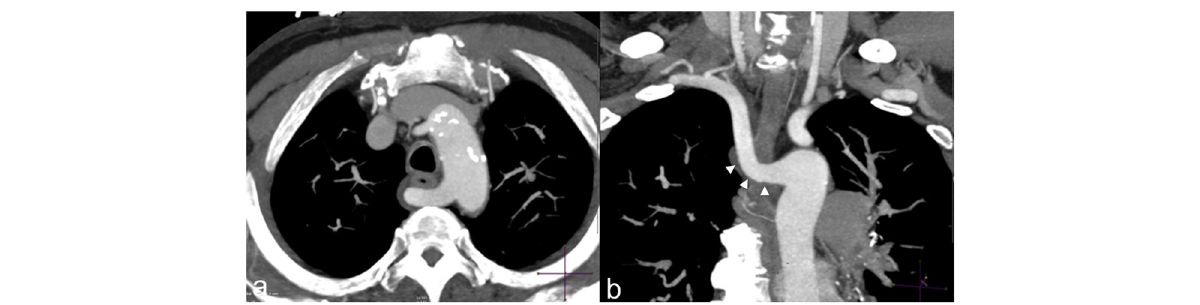
Fig. 16 Aberrant right subclavian artery. Axial ( a ) and coronal ( b ) MIP thin reconstruction of a CT angiography of chest showing aberrant retroesophageal course of the right subclavian artery